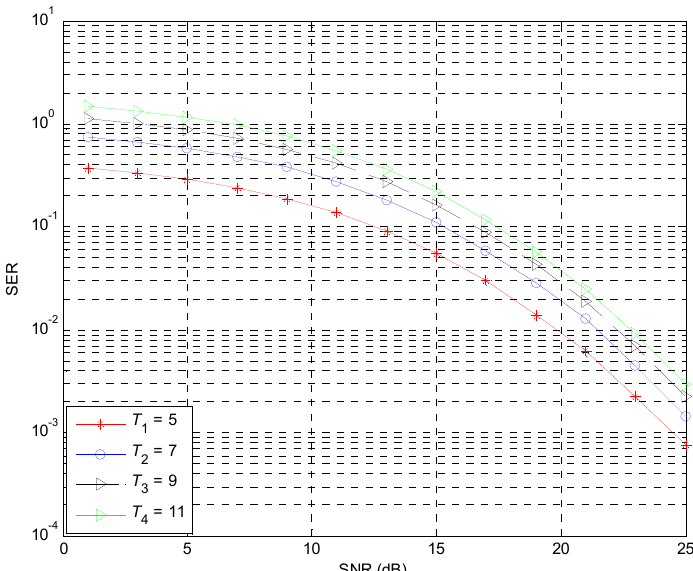
Figure 3. Symbol error rate (SER) performance of the 16 QAM-modulated CP-OFDM system over static China digital television (DTV) Test 1st (CDT1). SNR: signal-to-noise ratio.